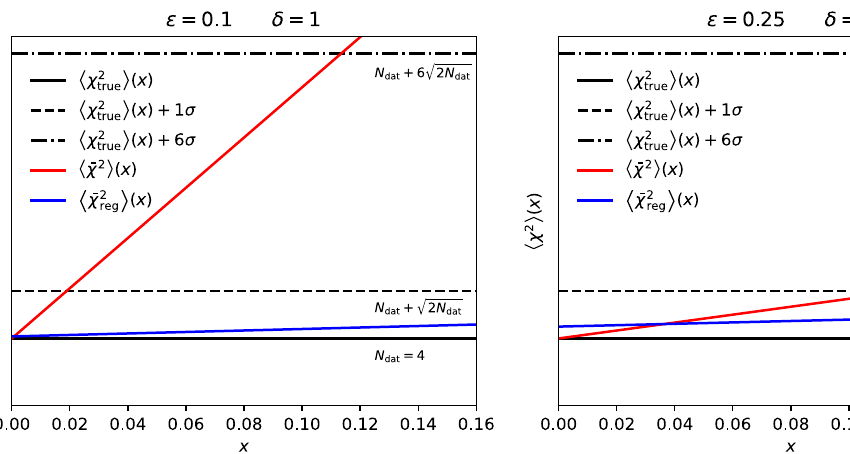
(cid:5) ¯ χ 2 (cid:6) , given the inaccurate matrix of uncertainties ¯ A , Eq. (28); and the expectation value of Eq. (36), (cid:5) ¯ χ 2 reg (cid:6) , given the matrix of uncertainties ¯ A reg ,Eq. (34), obtainedafterapplyingtheregularisationprocedure with δ =